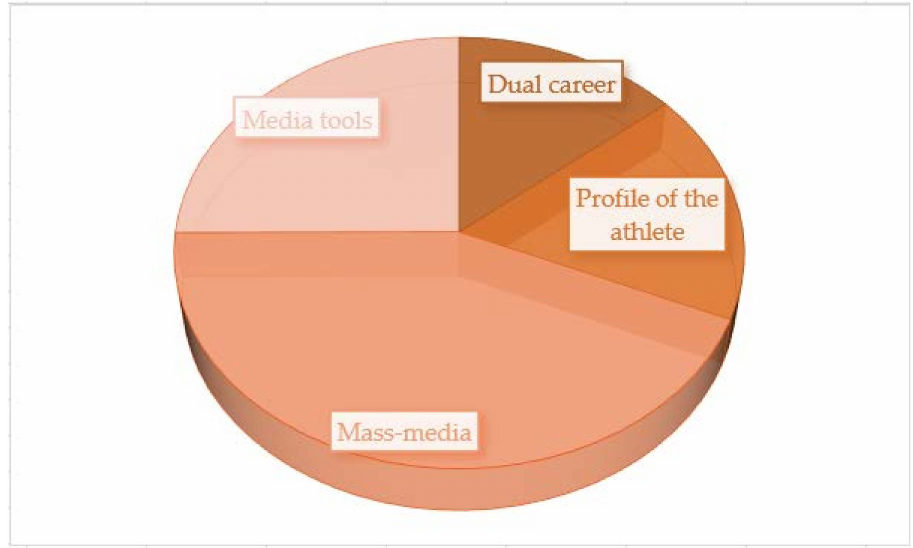
Figure 5. Hierarchy of content analysis categories for